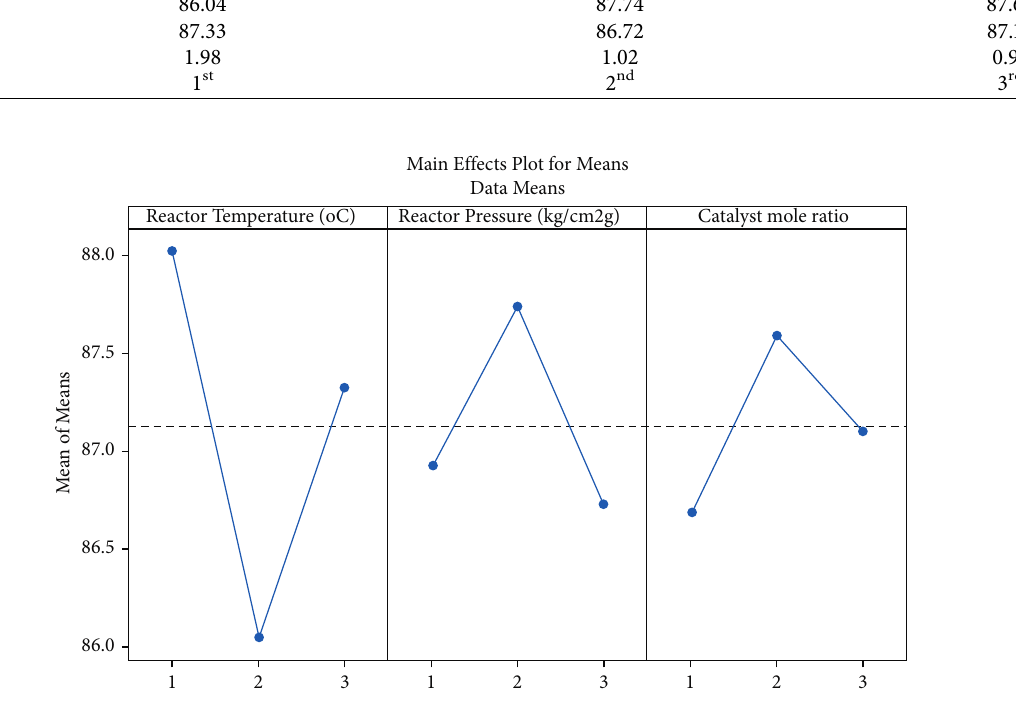
Figure 2: Relative mean of PPC% for each factor at three different